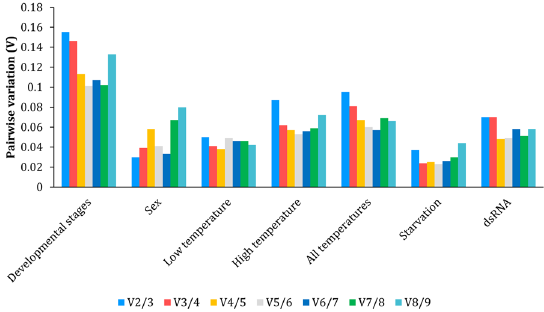
Figure 3. Determination of the optimal number of reference genes for accurate normalization using pairwise variation (Vn/n + 1) analysis by geNorm.